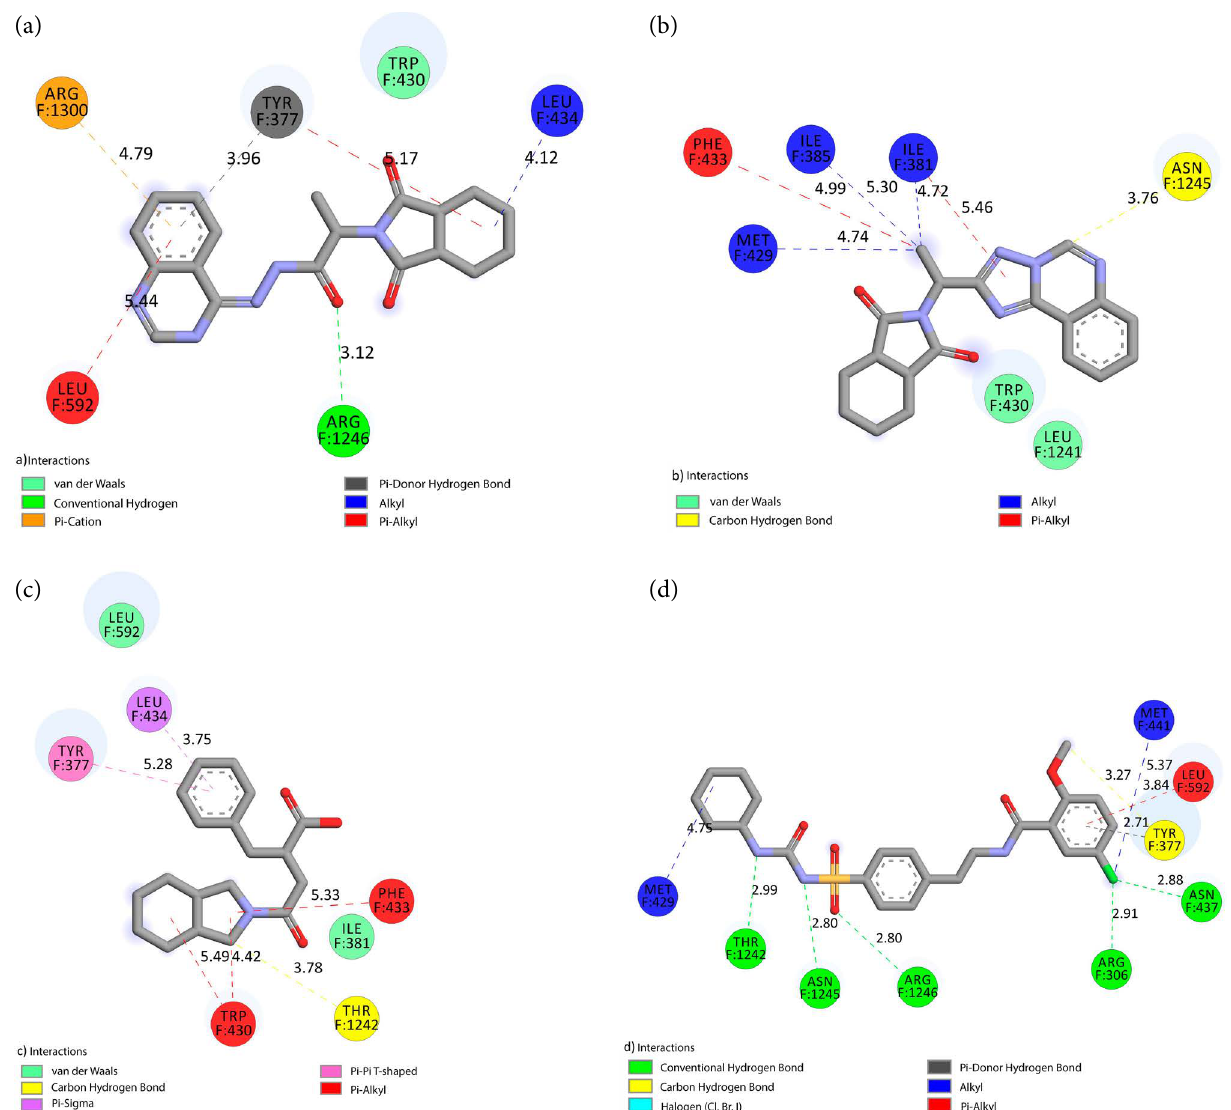
Figure 2. Visualization of affinity according to the docking (а) compound 3a with KATP channel; (b) compound 4a with KATP channel; (с) Mit- iglinide with KATP channel; (d) Glibenclamide with KATP